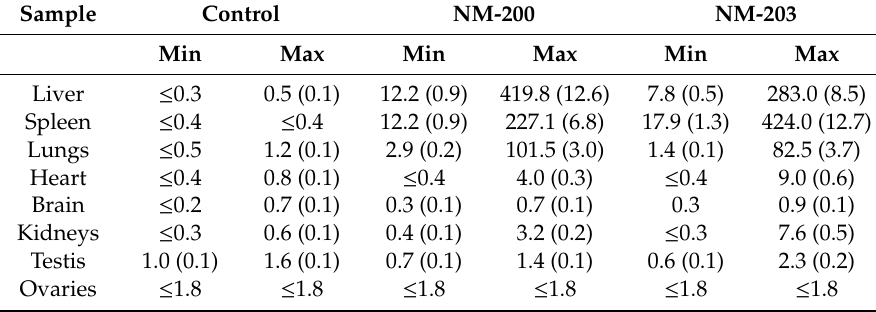
Table 5. Total Si concentration range measured in rat tissues after IV repeated dose. Results are expressed as µ g Si g − 1 . Measurements error are expressed as standard deviation in